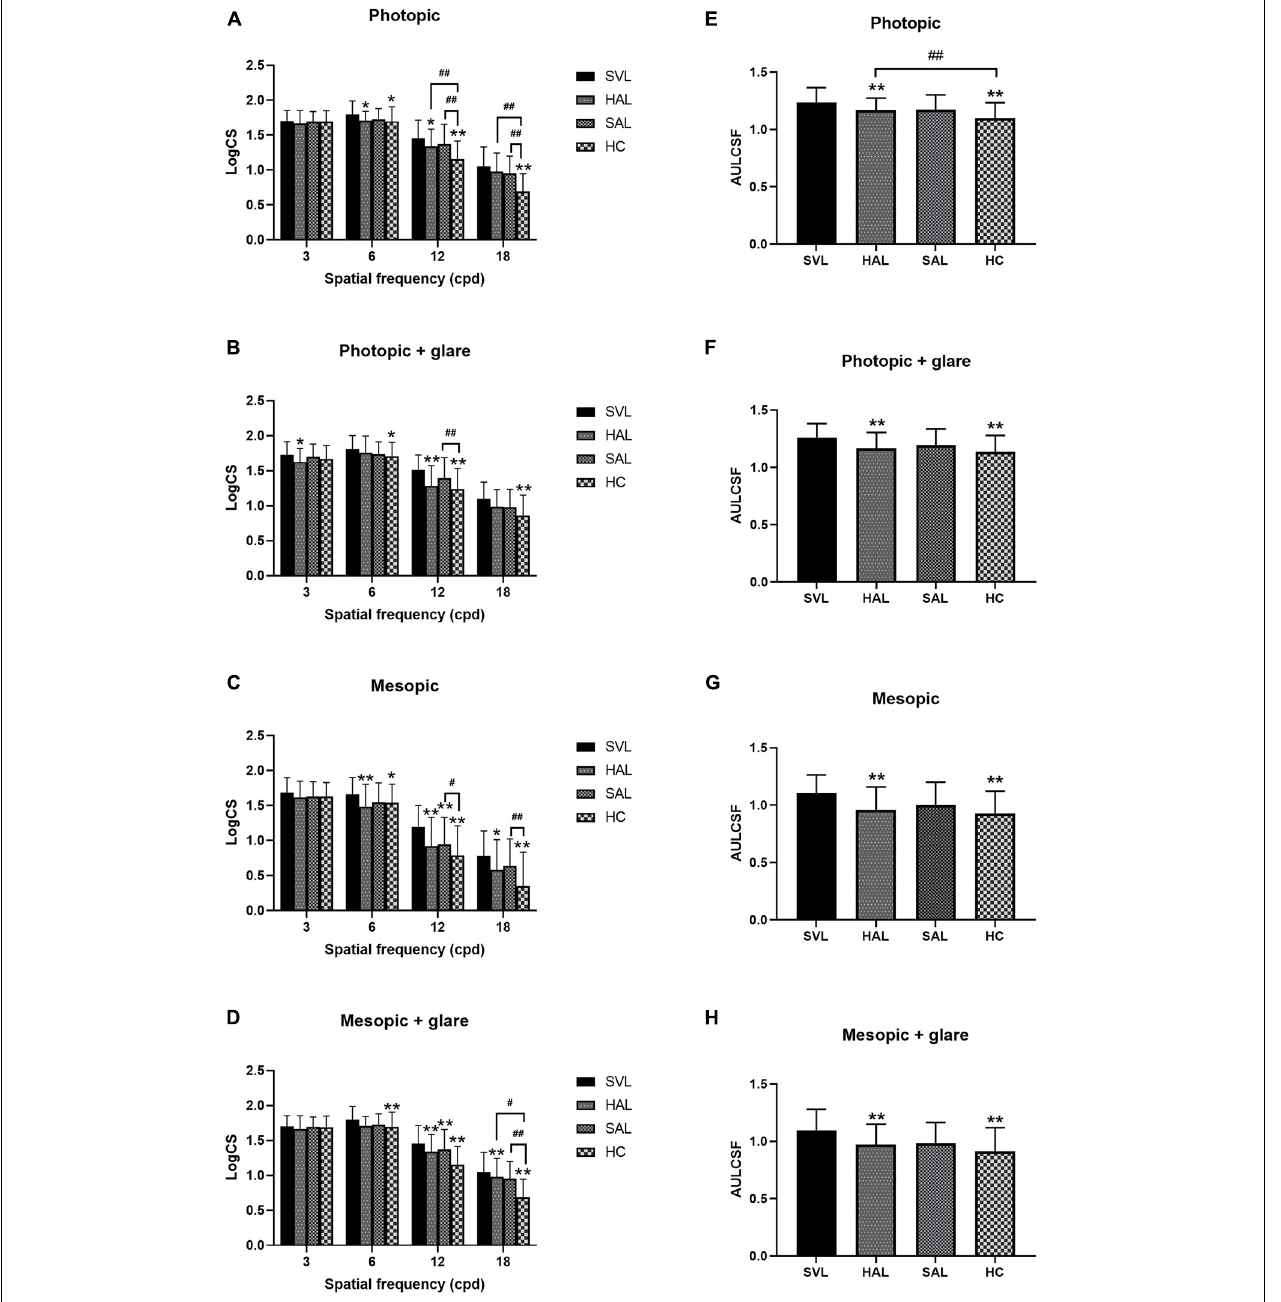
FIGURE 6 | Mean log contrast sensitivity (A–D) and area under the log contrast sensitivity function (AULCSF) (E–H) with standard deviations of four tested spectacle lenses in photopic (A,B,E,F) and mesopic (C,D,G,H) conditions, with (B,D,F,H) and without (A,C,E,G) glare. (SVL for single-vision lens, HAL for spectacle lenses with concentric rings of highly aspherical lenslets, SAL for spectacle lenses with concentric rings of slightly aspherical lenslets, and HC for lenses with spherical lenslets in honeycomb configuration) N = 36. Asterisk (*) and number sign (#) represent significance in the Bonferroni post hoc test following the repeated measures ANOVA. * p < 0.05, ** p < 0.01, data compared with SVL; # p < 0.05, ## p < 0.01, data compared between pairs of spectacle lenses with